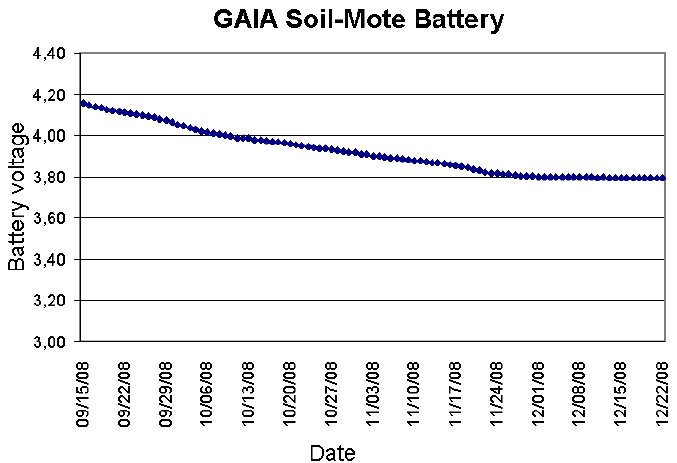
Figure 6. Evolution of battery rundown during laboratory